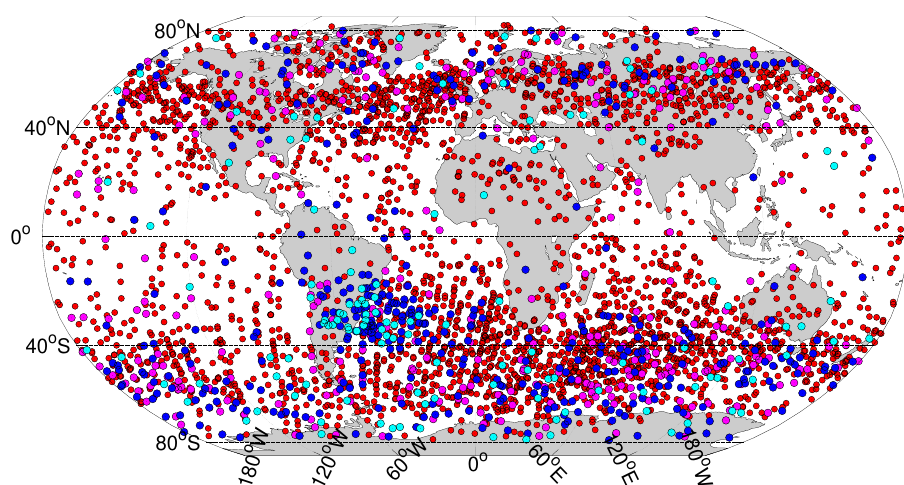
Figure 14. Geographical distribution of instant track-like flashes. Colors denote ranges of amplitudes: cyan, blue and ma- genta mark amplitudes ≤ 200, 400, 800 respectively. Flashes with amplitudes > 800 are shown in